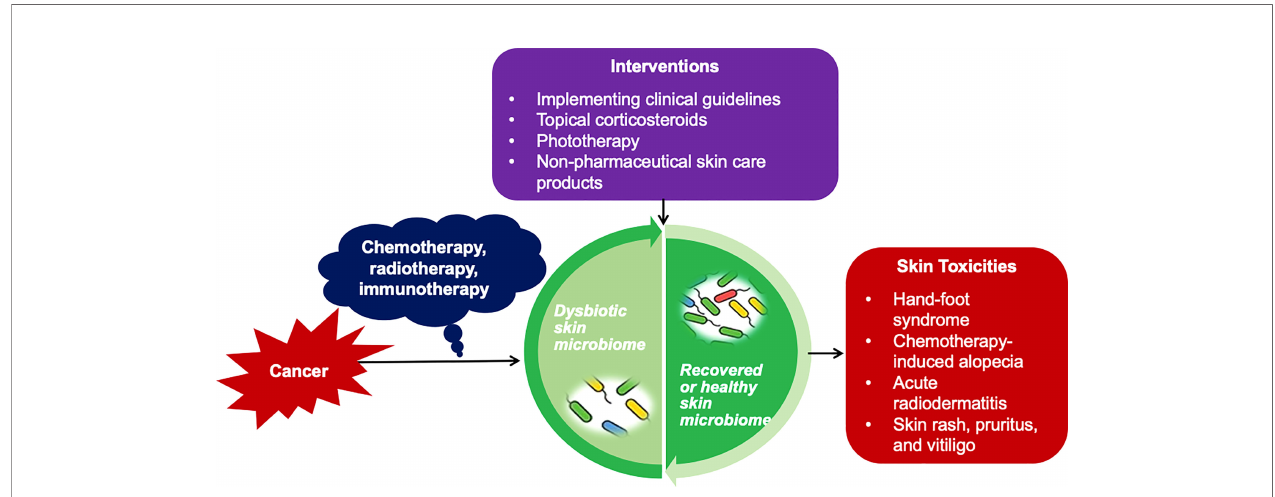
FIGURE 1 | Impact of Skin Microbiome on Cancer Treatment-related Skin Toxicities and Potential Interventions. Based on current knowledge of the bacterial microbiome in cancer treatment-related toxicities, implementing clinical guidelines, topical corticosteroids, phototherapy, and non-pharmaceutical skin care products are suggested approaches for the early prevention and management of cancer treatment-related skin toxicities via adjusting the skin microbiome, and eventually improve patients' quality of